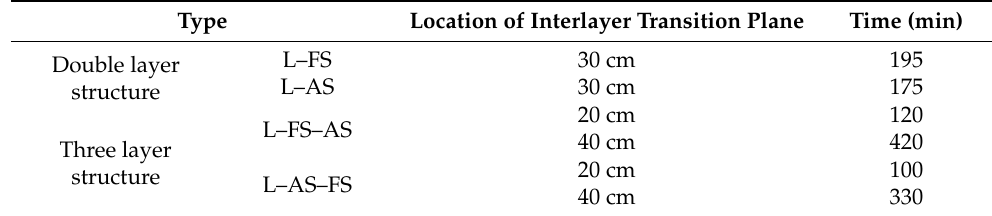
Table 3. Time needed for wetting front reaching the interlayer transition